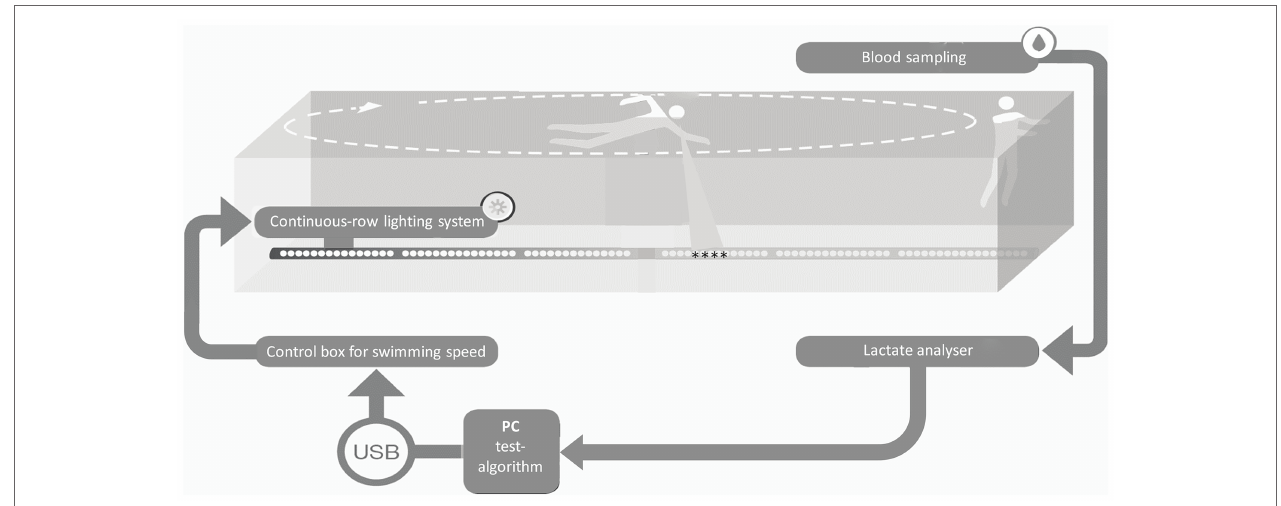
FIGURE 1 | Experimental arrangement of the individual lactate threshold-test in